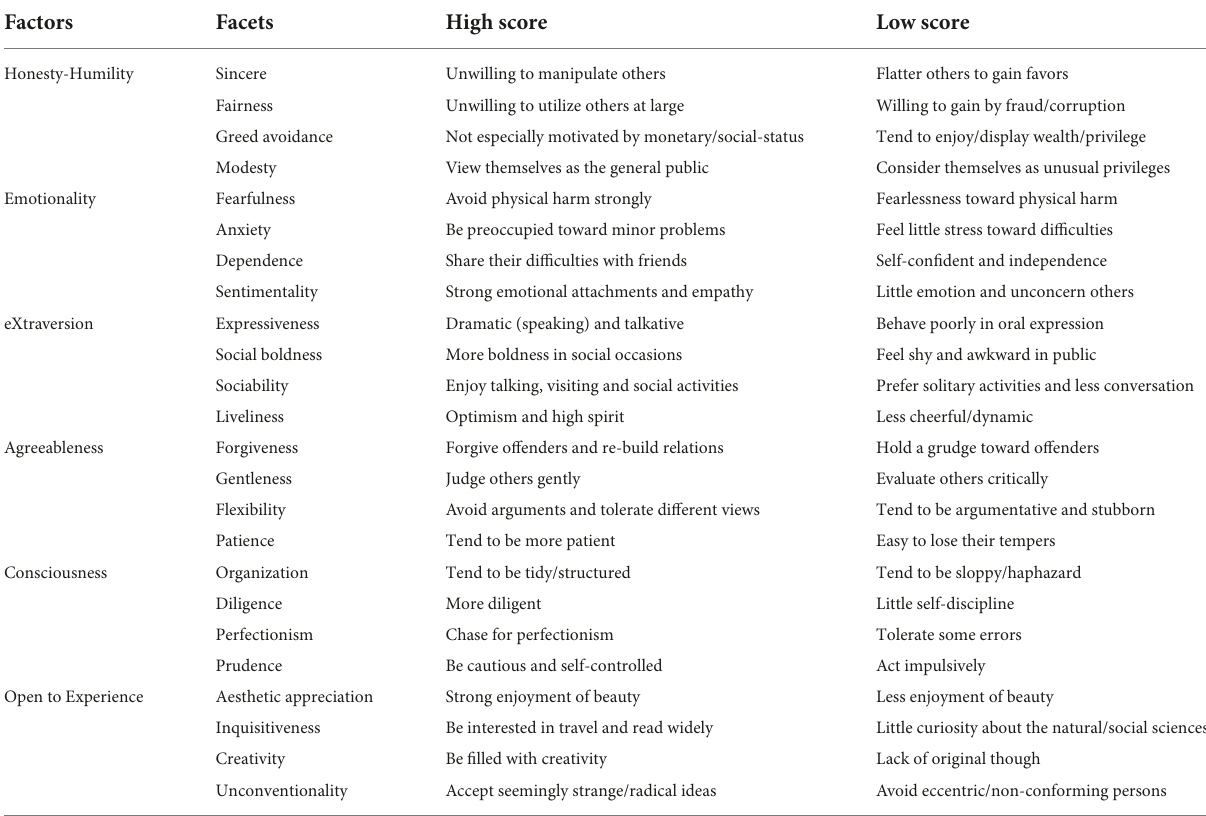
TABLE 1 The main facets and interpretations of the HEXACO